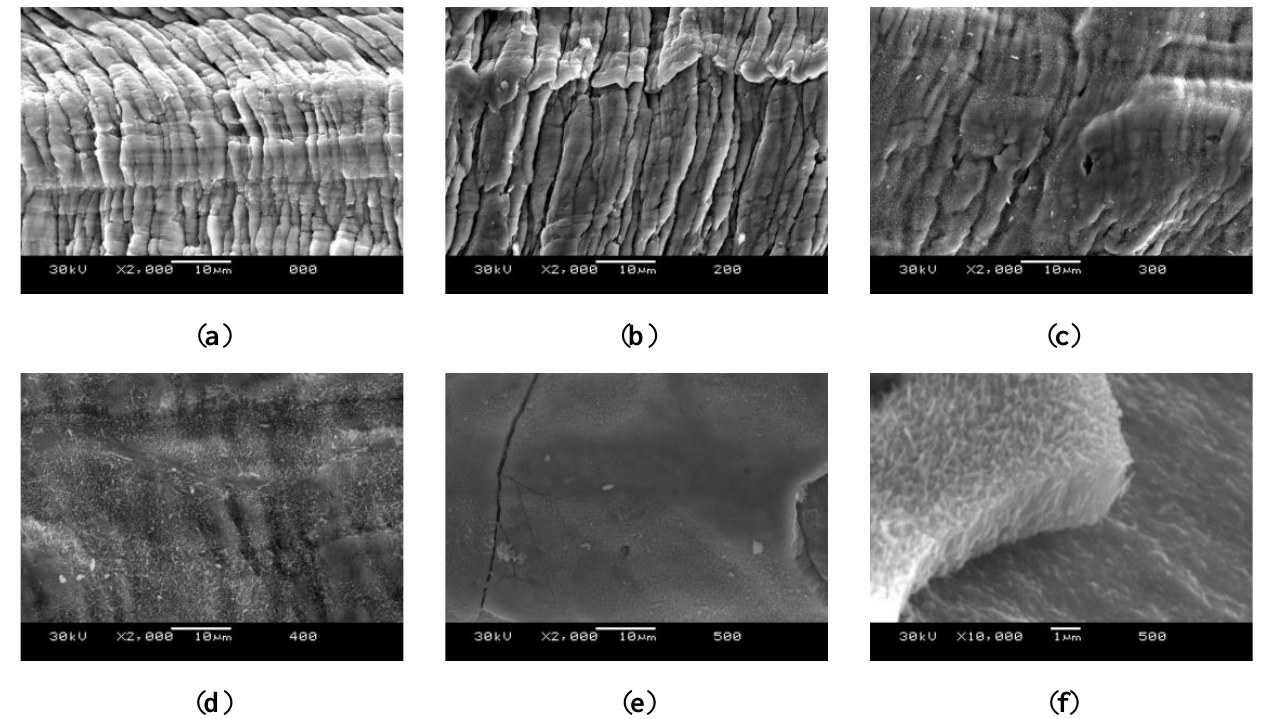
Figure 4. Scanning electro-microscopy (SEM) analysis of the wool samples after thermal treatment under an inert atmosphere. ( a ) Initial sample, ( b ) sample treated at 200 ◦ C, ( c ) sample treated at 300 ◦ C, ( d ) sample treated at 400 ◦ C, ( e ) sample treated at 500 ◦ C, and ( f ) detail of the superficial layer of the sample treated at 500 ◦ C.